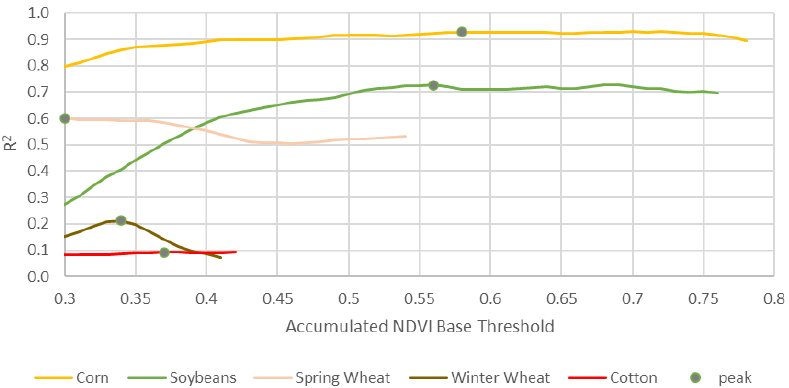
Figure 3. R 2 optimization versus threshold in the accumulated NDVI methodology. The left side of the chart was bounded by 0.3 as that was the point at which NDVI typically reaches a minimum off season. The right end of each line represents the minimum NDVI maximum that occurred during the period.